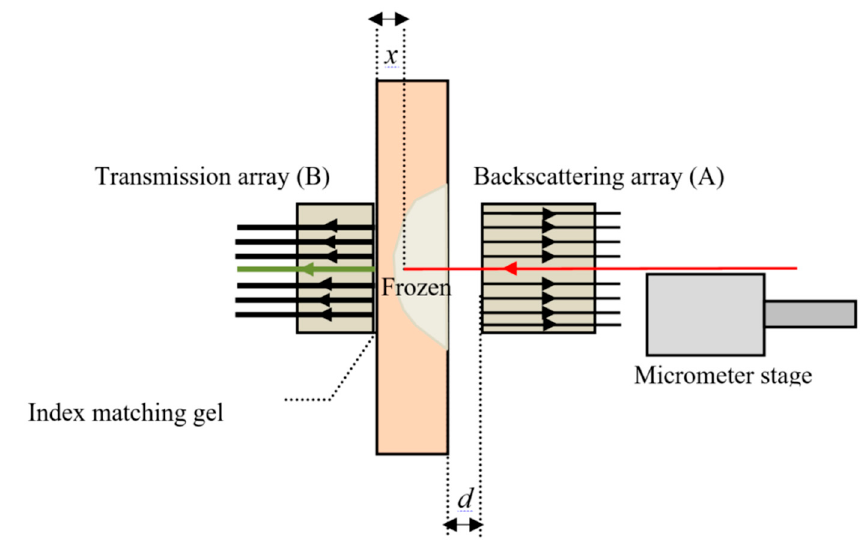
Figure 1. Experimental set up of calibration setup.